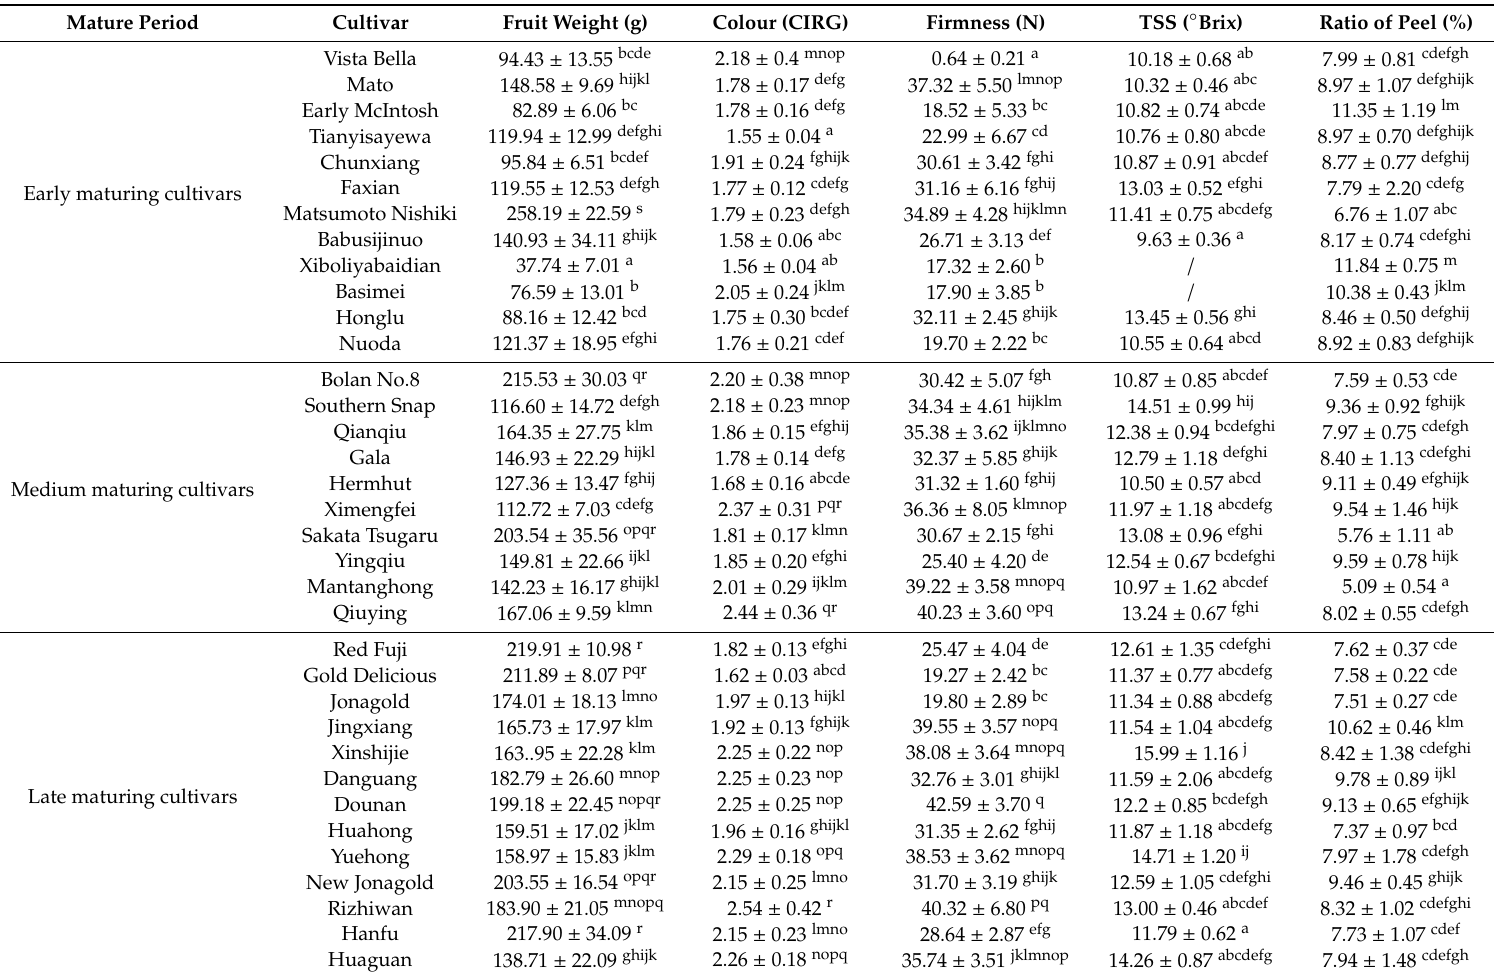
Table 1. Quality indexes of di ff erent apple